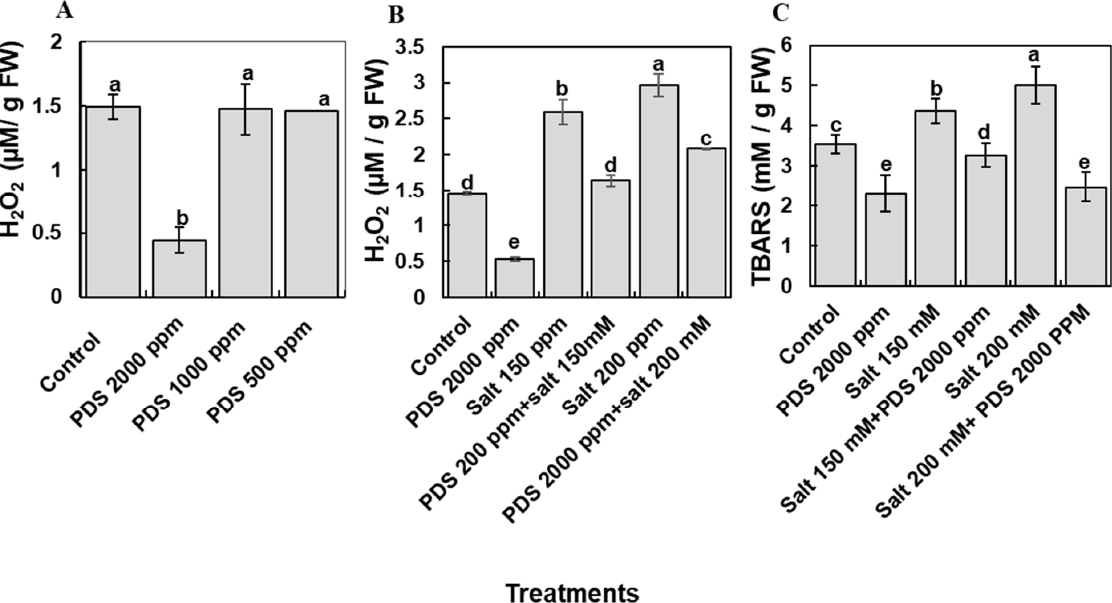
Figure 5. Effect of PDS on reactive oxygen species (ROS) (H 2 O 2 ) under normal and salt stress. ( A ) The level of H 2 O 2 was determined under PDS (2000, 1000, and 500 ppm). ( B ) Salt (150 and 200 mM), and salt supplemented with PDS 2000 ppm. Seven-day-old seedlings were harvested and subjected for the analysis of H 2 O 2 . Five seedlings were randomly selected from each treatment and H 2 O 2 was assessed. ( C ) Lipid peroxidation was analyzed in terms of TBARS using 7-day-old seedlings. Five seedlings were randomly collected from each treatment and TBARS was measured. Data are means ± SE obtained from three different batches of replicates. All data were analyzed using one-way ANOVA, with multiple comparisons using LSD test at a significance threshold of p ≤ 0.05 ( n = 5). The different lowercase alphabets represent homogeneous subsets and it’s indicates the statistical significantly according to Fisher LSD at level p <